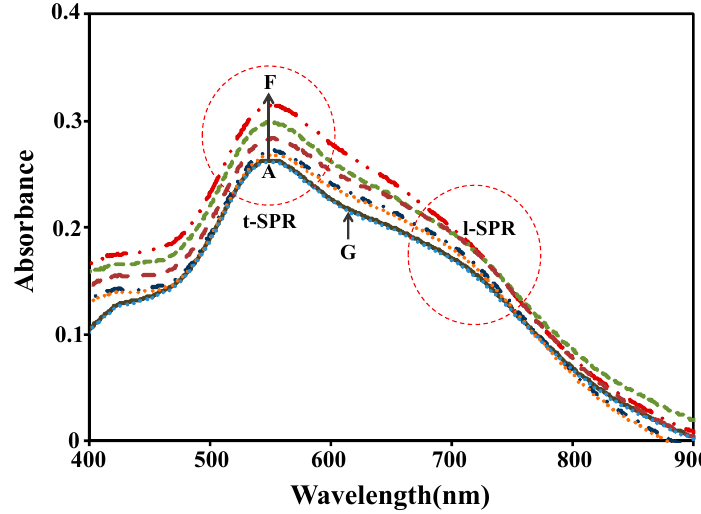
Figure 3. The plasmonic responses of Au nanoplates to the variation concentration of boric acid: ( A ) DI water, ( B ) 0.01mM, ( C ) 0.1 mM, ( D ) 1mM, ( E ) 10 mM, ( F ) 100 mM, and ( G ) 200 mM boric acid.